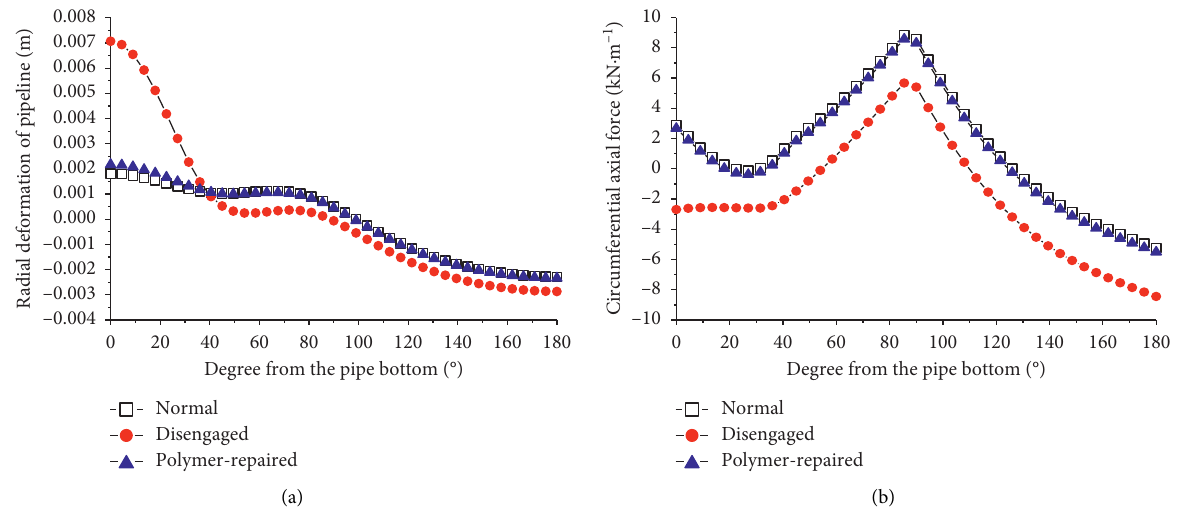
Figure 9: Calculation results of the Winkler model. (a) Radial deformation. (b) Circumferential axial